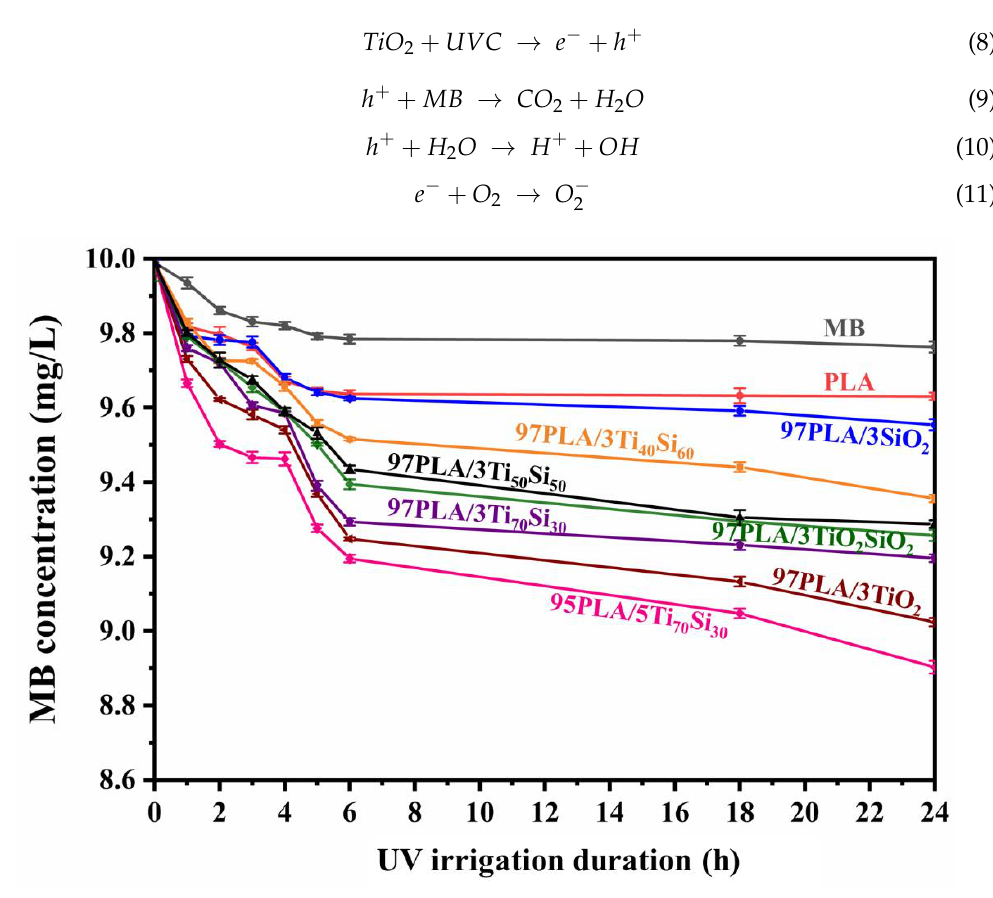
Figure 8. Concentration of methylene blue (MB) due to absorption of PLA, PLA/TiO 2 , PLA/SiO 2 , PLA/Ti x Si y , and PLA/TiO 2 SiO 2 composite films under UV irrigation.